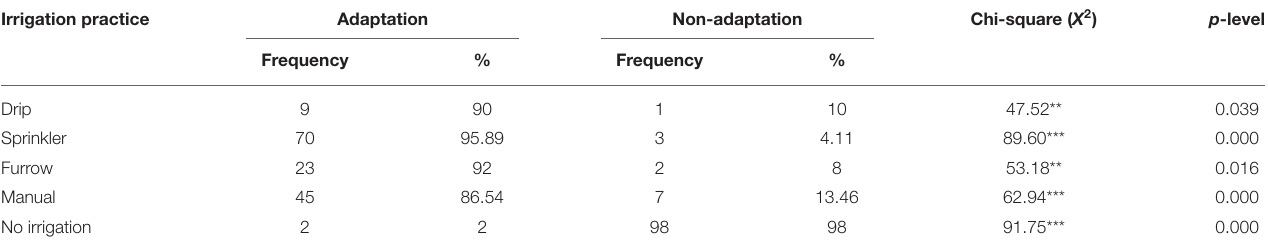
TABLE 4 | Chi-square test statistic showing differences in adaptation between market gardeners applying different irrigation practices. Irrigation practice Adaptation